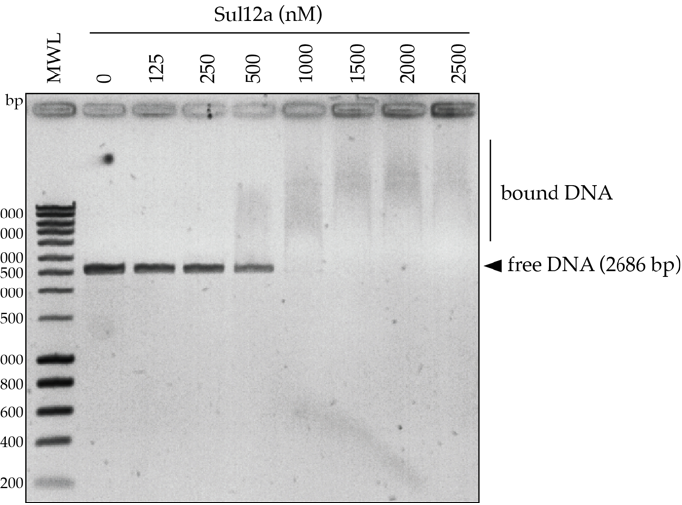
Figure 4. EMSA of Sul12a binding to linearized pUC18 plasmid DNA. Molar protein concentrations are indicated. Populations of free and bound DNA are indicated. MWL = molecular weight ladder.